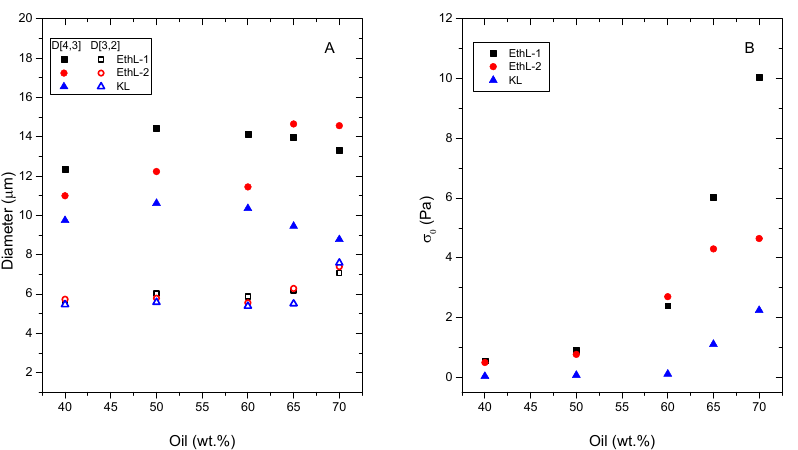
Figure 4. Effect of silicone oil concentration on emulsions parameters: ( A ) Sauter, D 3,2 and volumetric, D 4,3 , mean diameters; and ( B ) yield stress values determined from Herschel-Bulkley model. All emulsions were emulsified at pH 13, stabilized by 0.5 wt.% lignin and stored for 1 week.